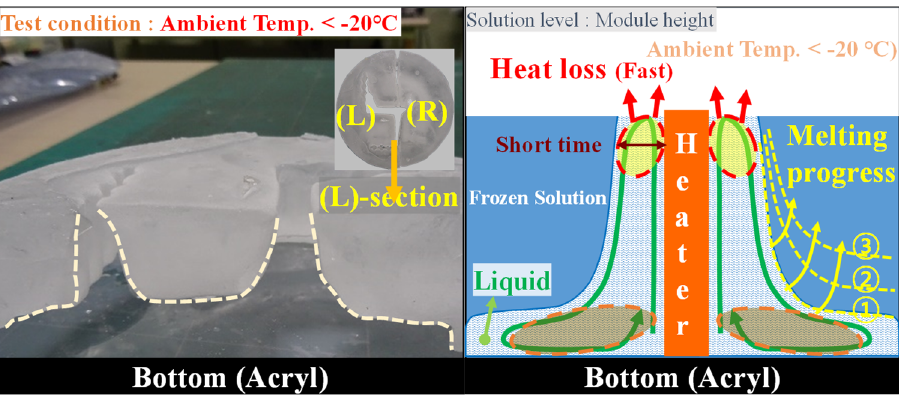
Figure 8. Section view of frozen solution and schematic of phenomenon according to time (Module_1); condition: Case_2 (level: Module height + extra level)/420 s.